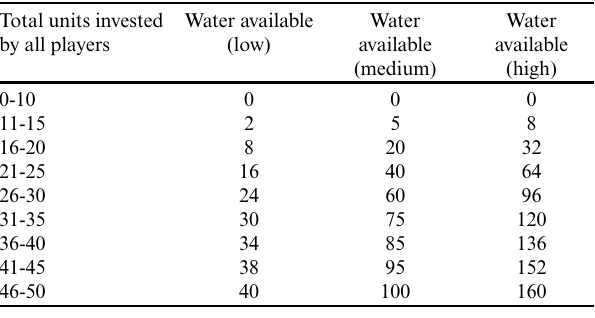
Table 2 . Water production as a function of units invested in the public infrastructure. The table includes a default production function (medium), as well as a production function during a dry round (low) and an affluent round